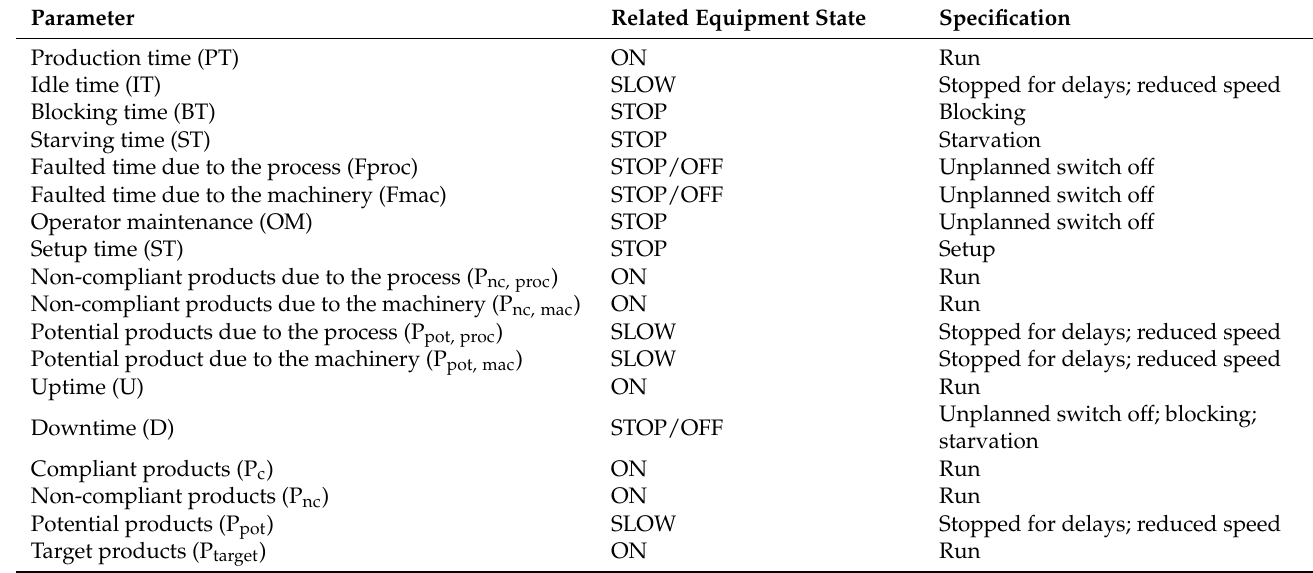
Table 5. Correspondence between the proposed metrics and the equipment states proposed by Schiraldi & Varisco (2020)